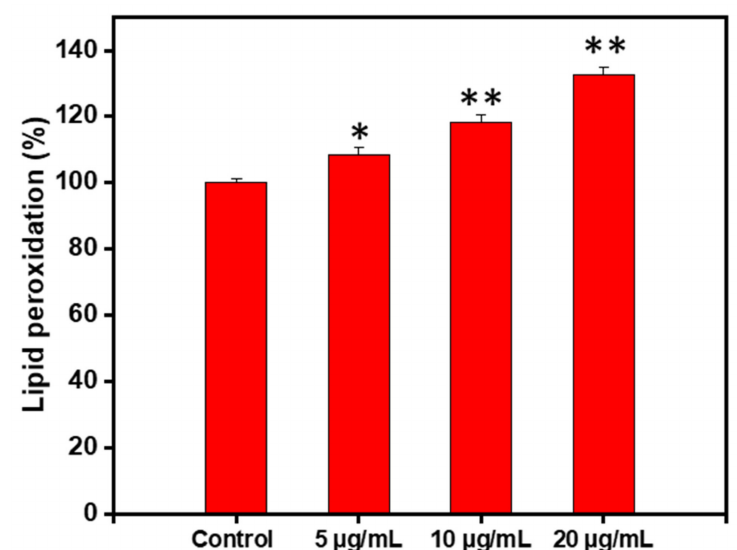
Figure 7. Percent change in lipid peroxidation in 4T1 cells treated for 1 h with TiO 2 NPs at the indicated concentration. Data are expressed as mean ± SD (* P < 0.05, ** P < 0.01 compared to untreated cells, used as NC).